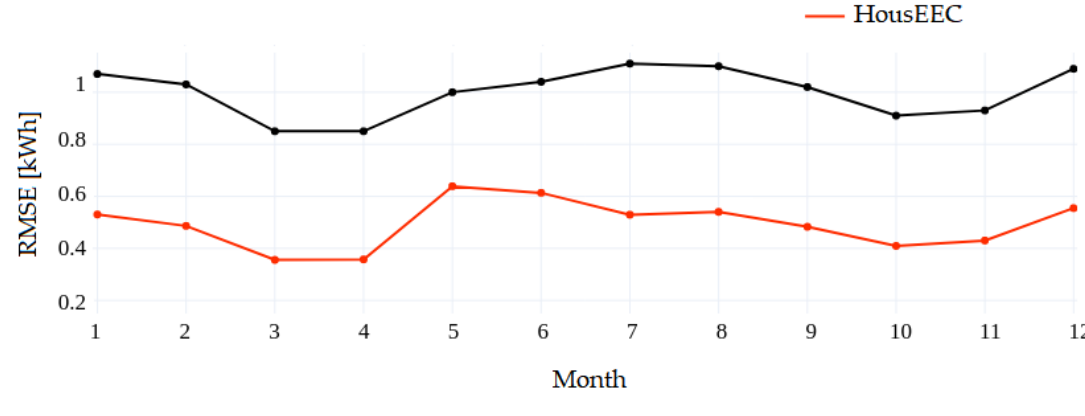
Figure 10. Root-mean-square error (RMSE) for each month of the year.